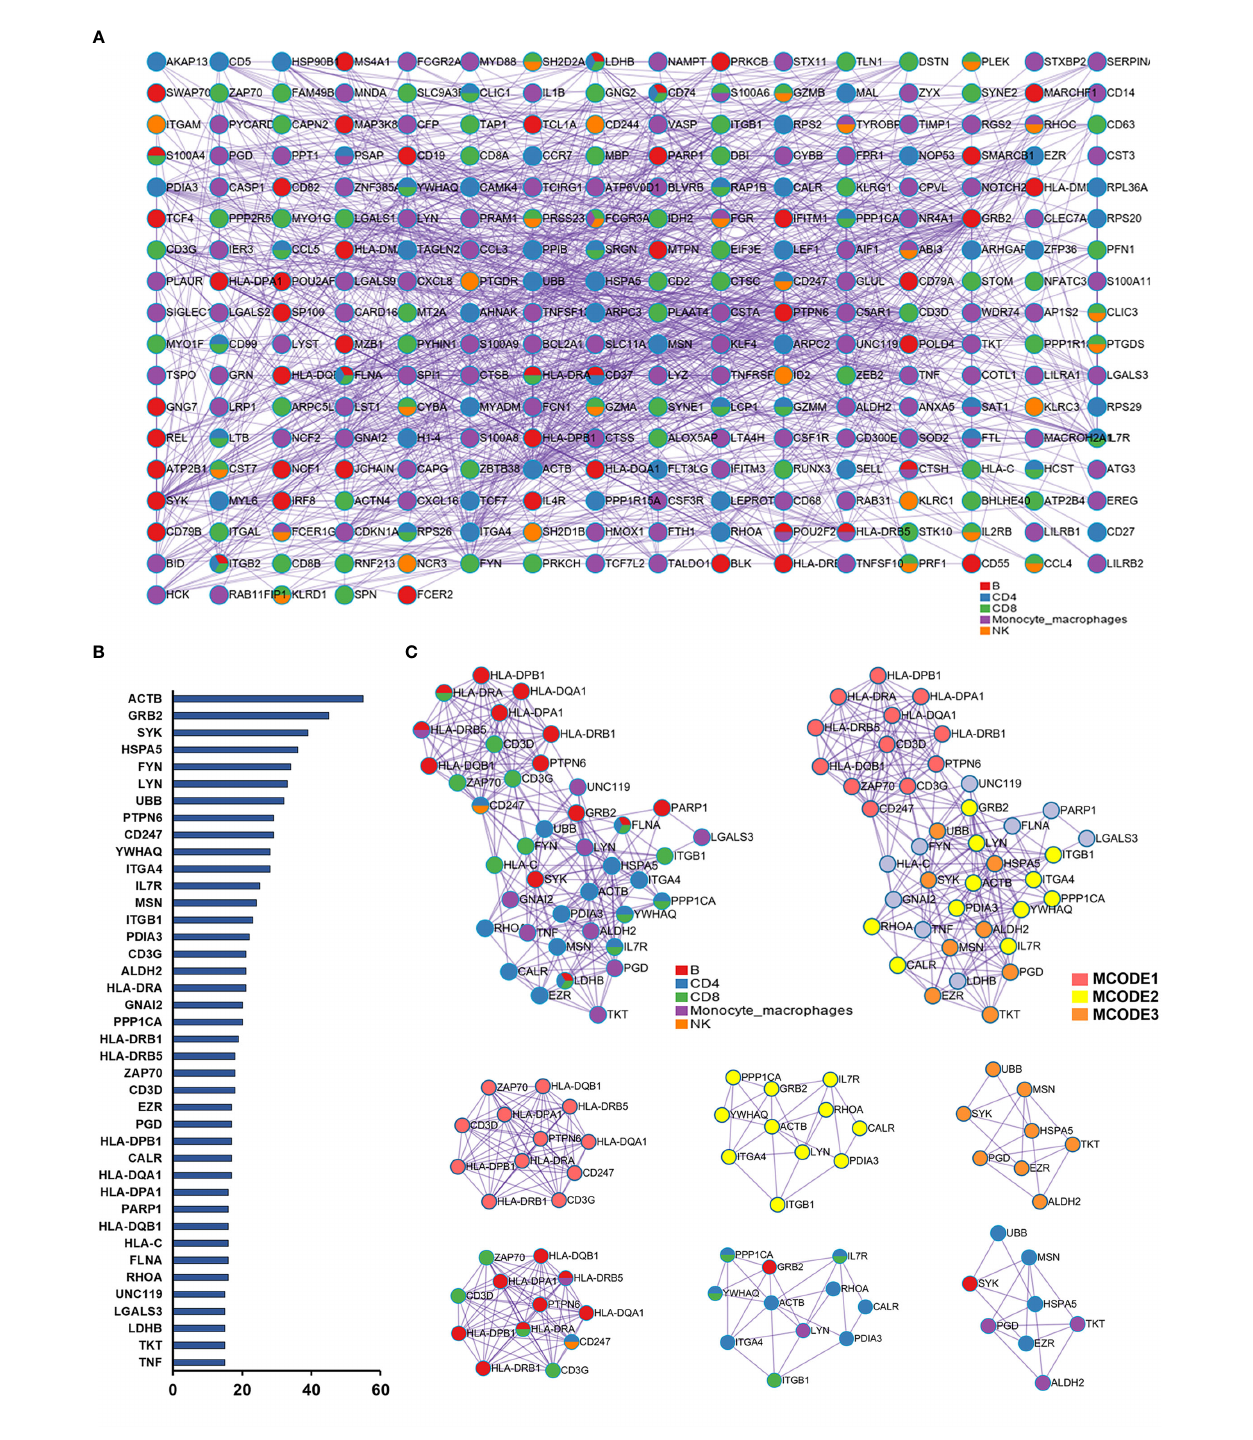
FIGURE 3 | Protein – protein interaction (PPI) networks analysis. (A) PPI network of the differential expression genes between the Alzheimer ’ s disease (AD) group and normal controls (NC) from CD4+ T cell, CD8+ T cell, natural killer (NK) cell, B cell, and monocyte – macrophage cell subsets. The nodes are colored based on different subsets. (B) The top 40 genes identi fi ed though degree values in the PPI network. (C) The PPI subnetwork is constructed from the top 40 genes; three modules were identi fi ed by using the molecular complex detection (MCODE) algorithm, which comprised 31 key